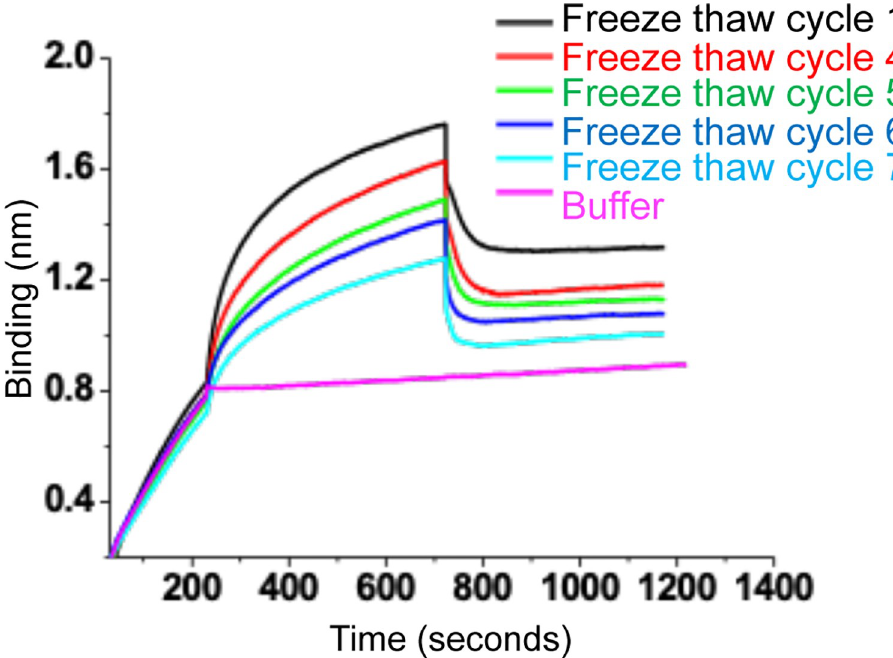
Fig 5. A mixture of wild type N protein generated by mixing equal volumes of fraction 1–4 (Fig 2) at a final concentration of 125 nM was tested for RNA binding after different freeze thaw cycles. The BLI sensograms in different colors demonstrating association and dissociation kinetics of N protein with the RNA after different freeze thaw cycles are shown.